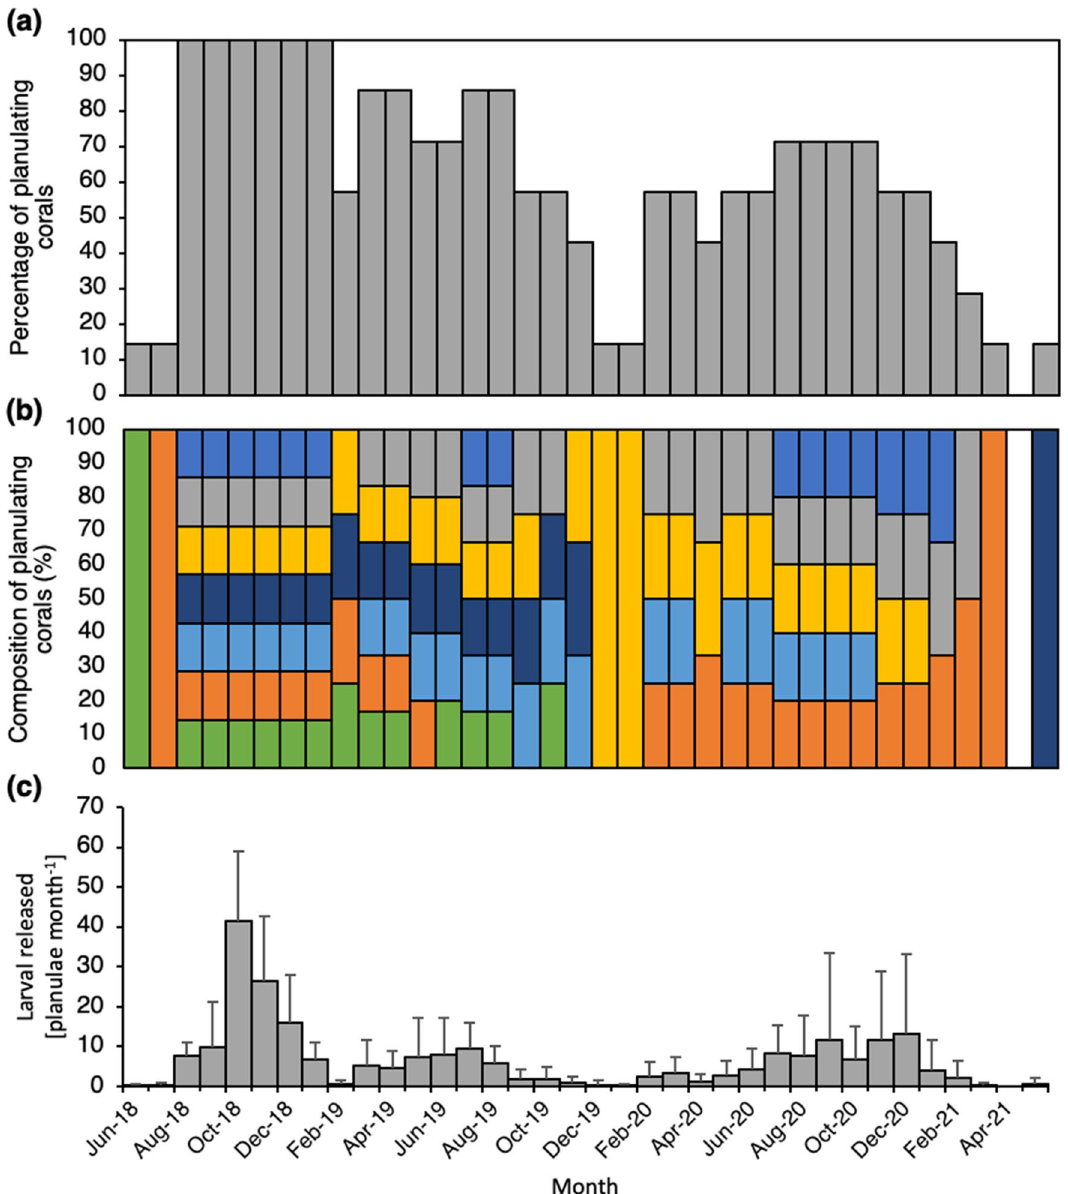
Figure 2. Seasonal and interannual variability of the planulation activity of Caryophyllia huinayensis . ( a ) Percentage of planulating corals, ( b ) composition of planulating corals, with color-coded bars representing each of the seven parental polyps included in the study. ( c ) Larval release rate (mean ± SD) per month among all parental polyps. Note: No larvae were released in April Histologically, the larvae featured the typical bilayered tissue with a uniformly ciliated (ci) epidermis (ep), a thin layer of mesoglea (m), and an endodermis (en) with mesenterial filaments (me) which attach to the phar- ynx (ph), i.e., the muscular throat region (Fig. 4a,b). Like other cnidarian larvae, the aboral end likely holds the sensory organ (or the apical organ), being a pseudo-stratified epidermis (pse) with sensory cells that detect the exogenous chemical cues for settlement (Fig. 4a). On a total of 25 larvae, the pharynx at the oral end connected the blastopore/oral pore (*) (Fig. 4b) with the gastrovascular cavity opening (gco) (Fig. 4c). During the first two days after release, most larvae swam near the water surface, but for the remainder of the larval period they swam mainly near the bottom, where no benthic crawling was observed. Swimming occurred in the apical direction with a superimposed counterclockwise rotation, so that the planula moved forward in a corkscrew-like manner with a swimming velocity of 1.18 ± 0.4 mm s −1 (n = 12). Attachment was sometimes followed by detachment until successful settlement and subsequent metamorphosis. If temporary attachment occurred, the planula detached after a maximum of 24 h and started its searching behaviour again. The planktonic stage lasted 8 ± 9.3 d (Stage 1, Fig. 5a) when settlement surfaces were preconditioned. However, larvae exposed to non-preconditioned surfaces had a longer PLD, 26.7 ± 2.1 d (n = 4). Three of four of these eventually settled,